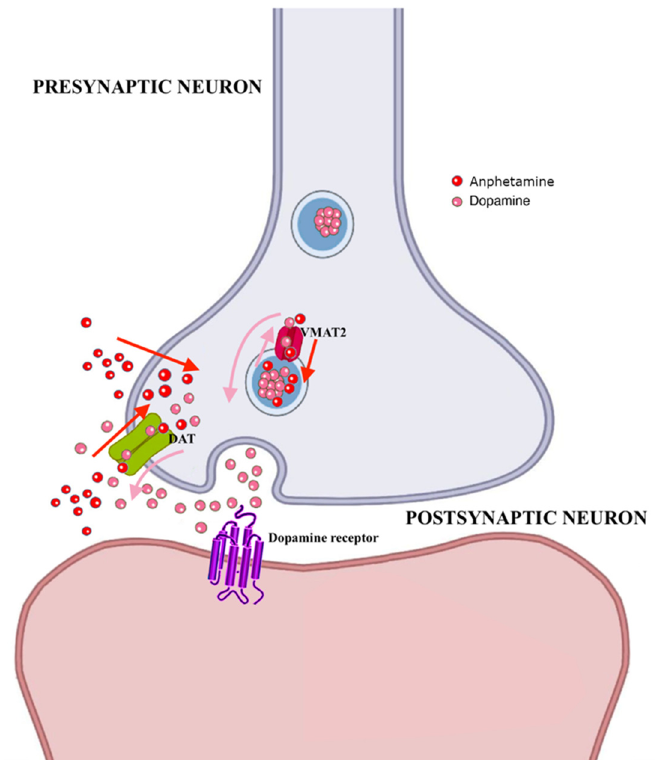
Figure 4 . Molecular mechanisms associated with amphetamine effects . Abbreviations: DAT: do- Figure 4. Molecular mechanisms associated with amphetamine effects. Abbreviations: DAT: pamine transporter, VMAT2: vesicular monoamine transporter 2. dopamine transporter, VMAT2: vesicular monoamine transporter